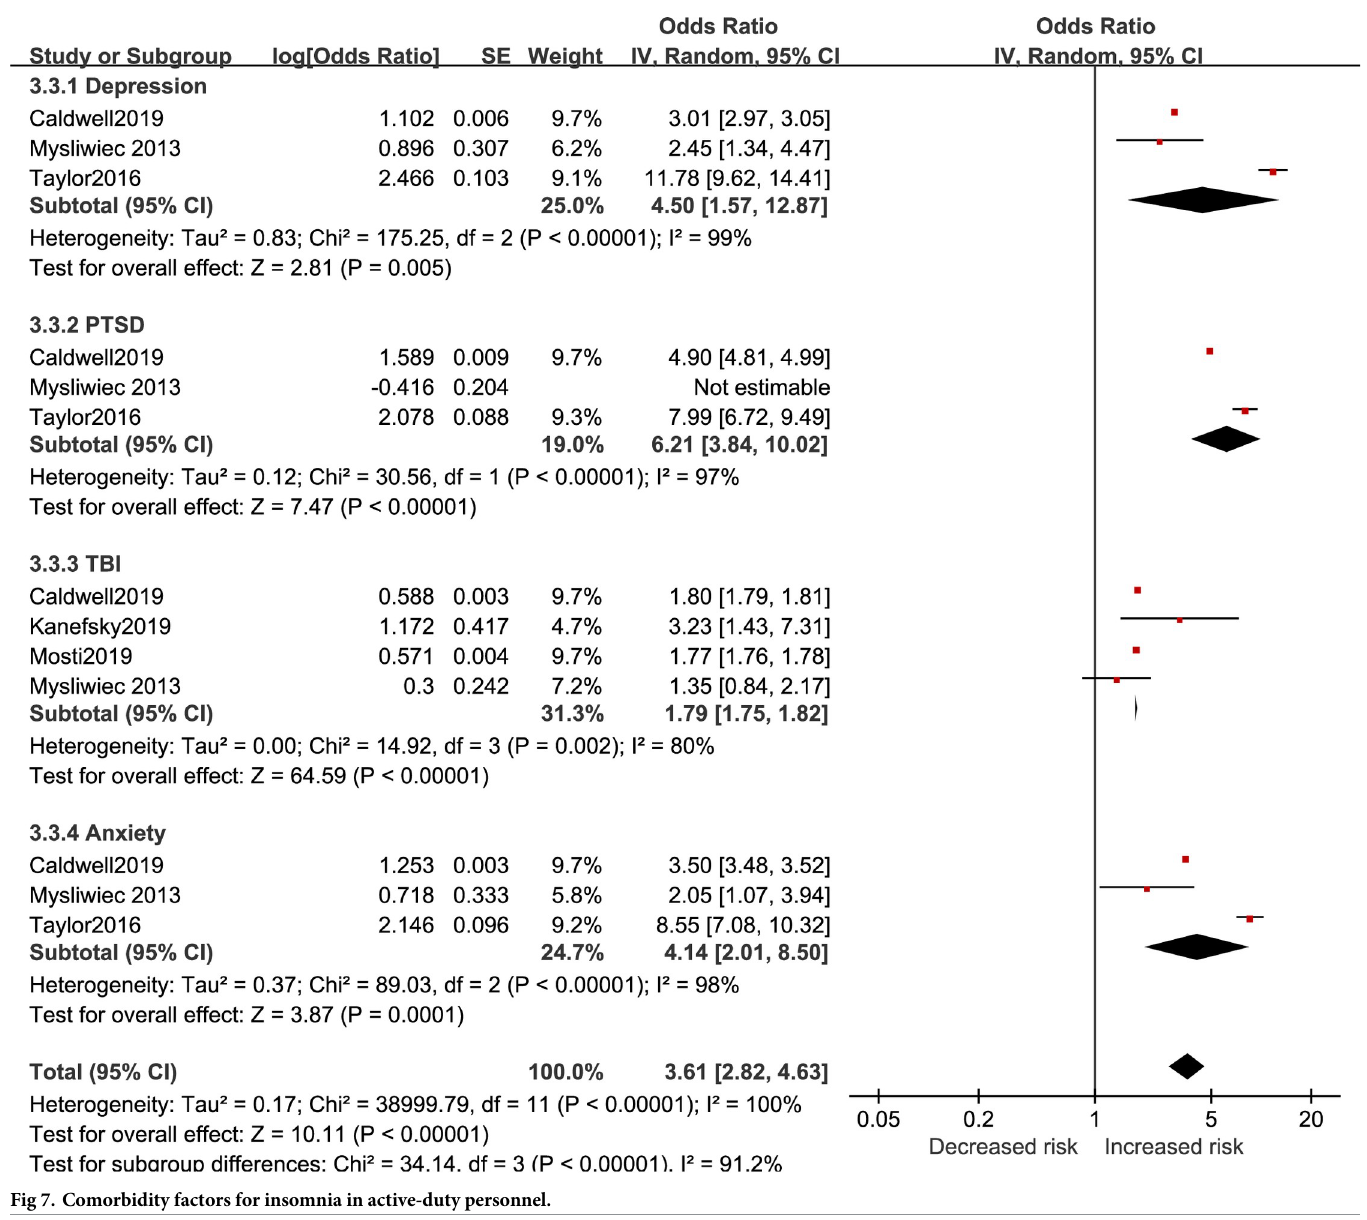
Fig 7. Comorbidity factors for insomnia in active-duty